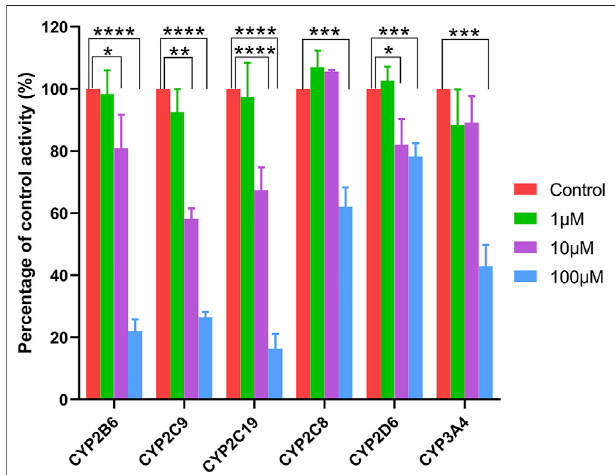
FIGURE 7 | Effects of ticagrelor-O-Glu on the activities of human CYPs enzymes. bupropion, amodiaquine, diclofenac, [S]-mephenytoin, dextromethorphan, and testosterone were used as the probe substrates for CYP2B6, CYP2C8, CYP2C9, CYP2C19, CYP2D6 and CYP3A4, respectively. Each bar represents the mean ± S.D. of triple incubations. *, p < 0.05; ***, p < 0.001, ****, p < 0.0001. Each bar represents the mean ± S.D. of triple incubations.